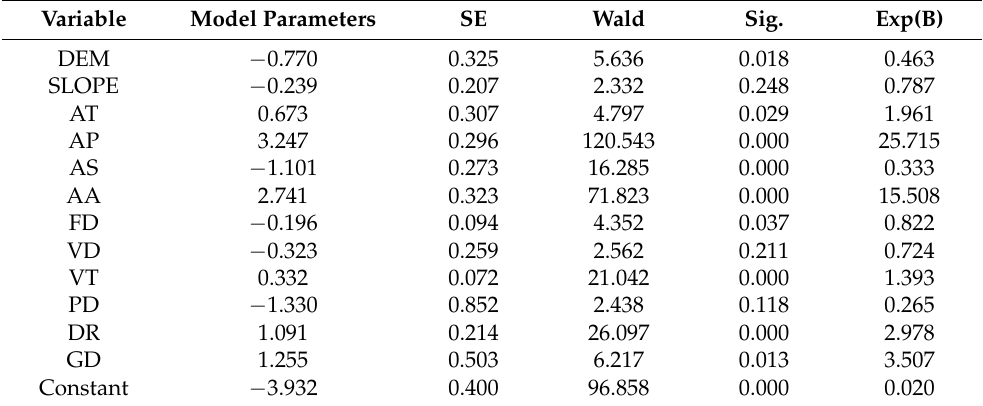
Table 3. Wildfire model variables and test results.